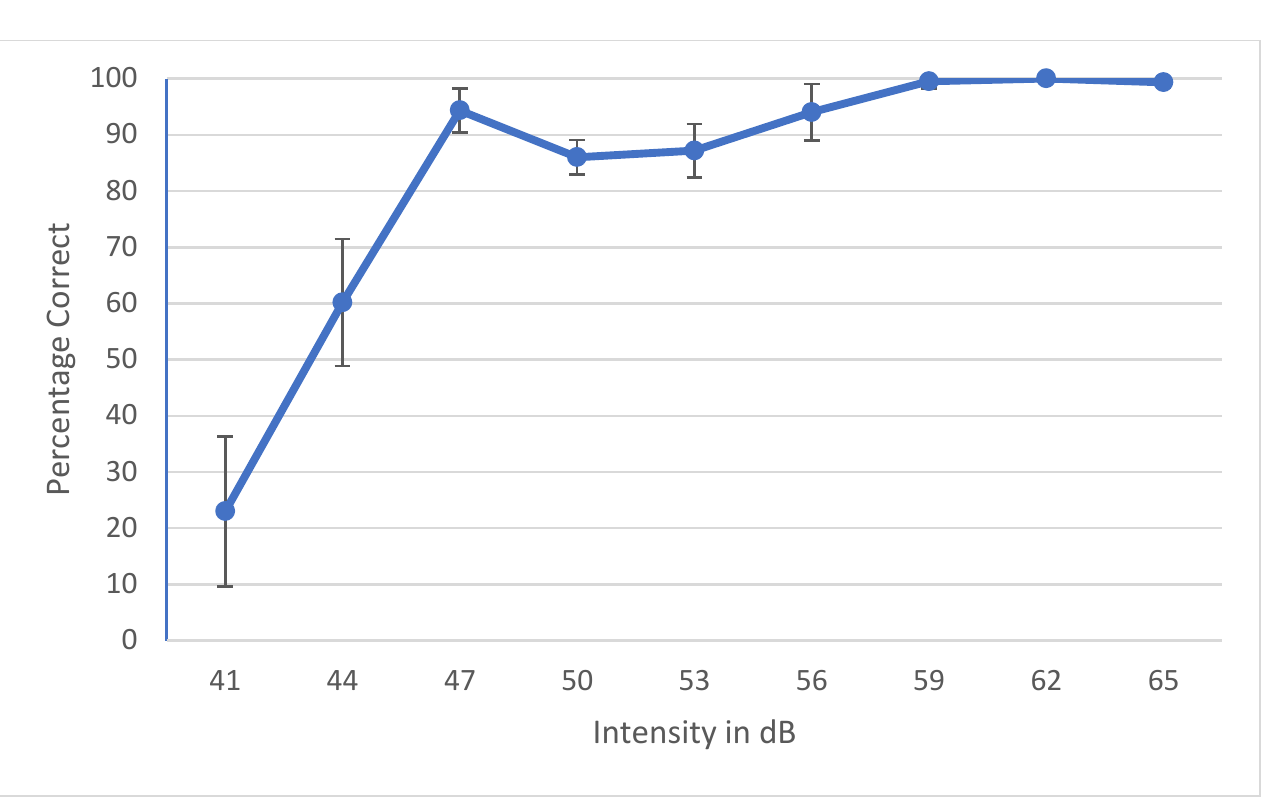
Figure 4. Average psychometric properties for the Maltese AAST words in adults in noise.